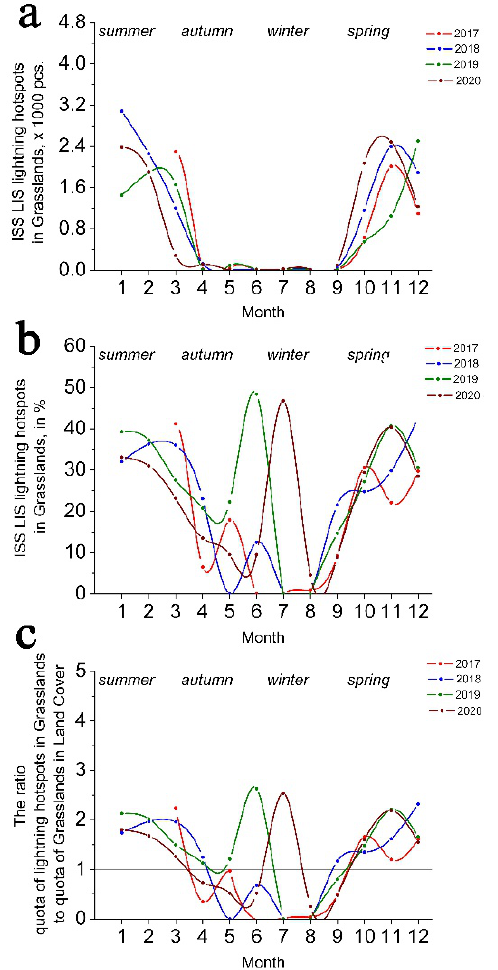
Figure 5. The monthly distributions of lightning hotspots (LIS ISS) recorded in grasslands, in pieces (pcs.), in percentages (%) of total monthly lightning hotspots, and the ratio of lightning attraction are drawn in ( a – c ), respectively. The months of 1–3 and 10–12 are involved in the Australian wet (thunderous) season, and 4–9 correspond to the dry season.